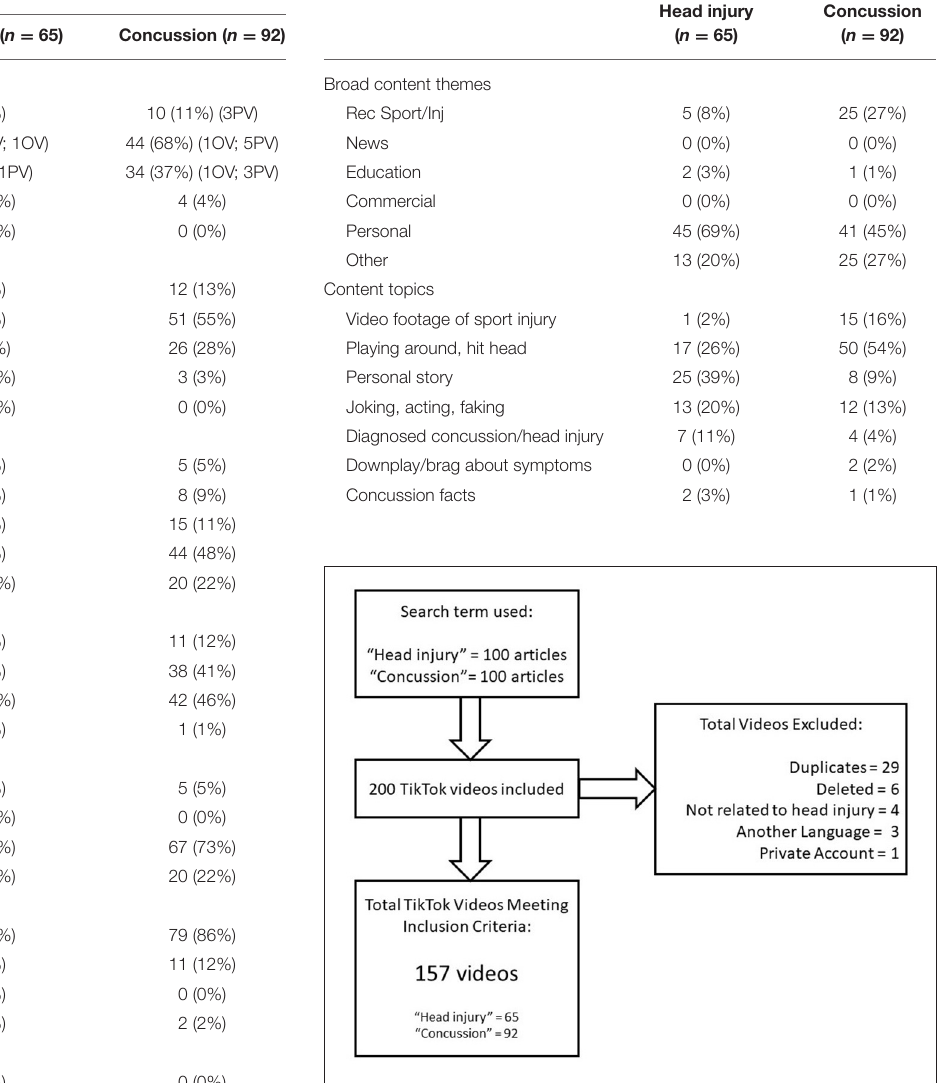
TABLE 2 | TikTok video descriptors for head injury and concussion labels (videos tallied for each category and reported as a percentage of total/number of verified people (PV) or verified organization (OV) reported).